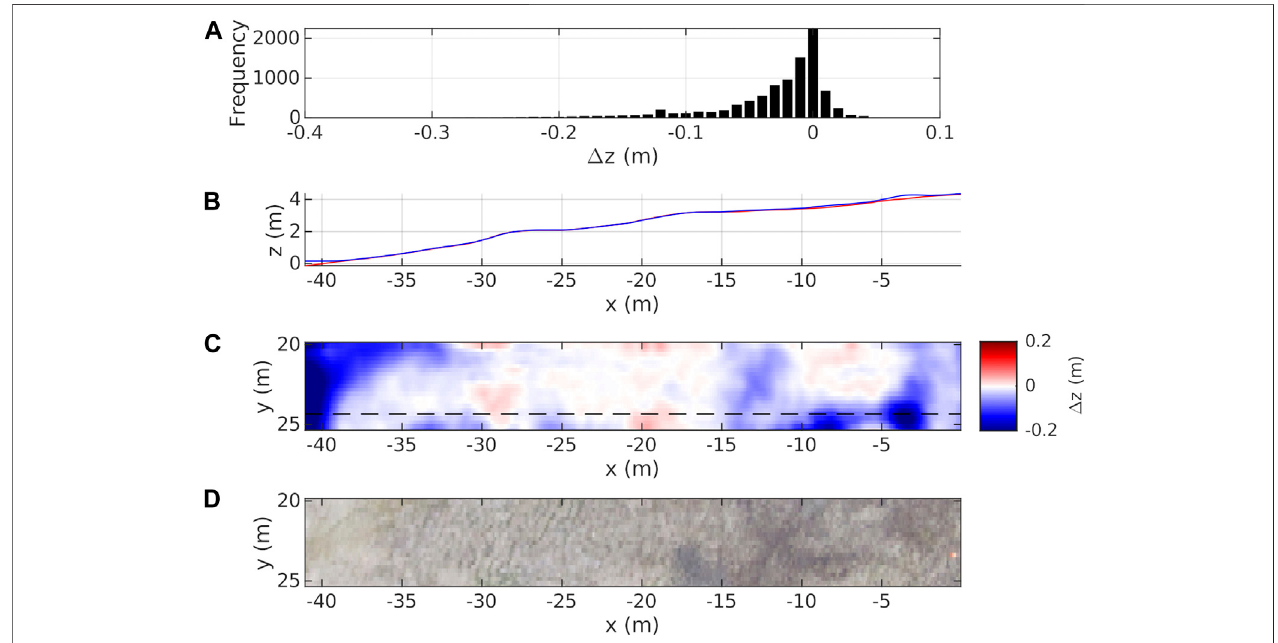
FIGURE4| DTMelevationchangefromspringtosummerinourstudyareaasseenin (A) thehistogramofheightdifferencesacrossallDTMgridcells, (B) extracted pro fi le [dashed linein (C) ]from summerDTM (red) and springDTM (blue), (C) amap ofelevation change from spring tosummer 2014, (D) detail oforthophoto extracted from Figure 1 .